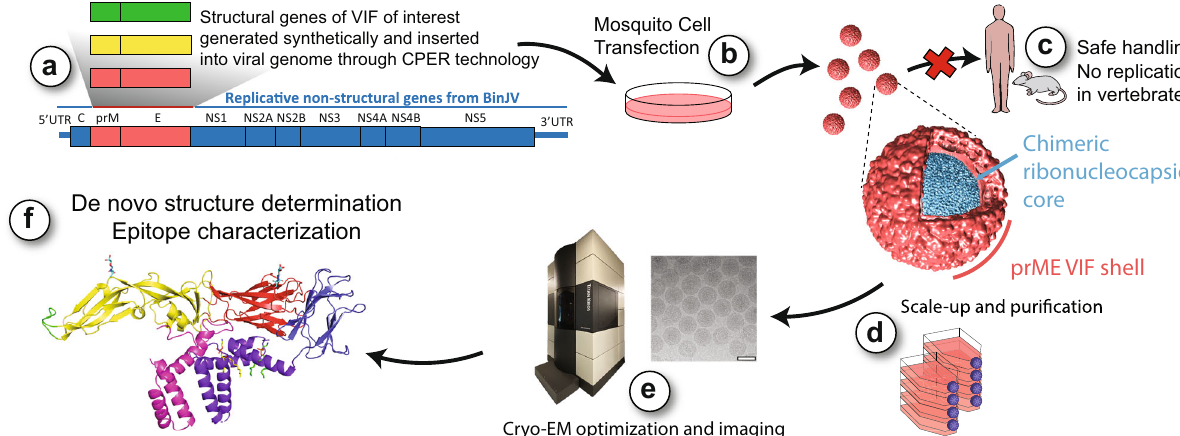
Fig. 1 A chimeric platform for high-resolution structure determination of fl aviviruses particles by cryo-EM. a Structural genes encoding prM and E proteins from a vertebrate-infecting fl avivirus (VIF) are used to replace the homologous genes of the ISF, BinJV, via circular polymerase extension reaction (CPER) methodology. b CPER product is transfected into insect cells to produce a chimeric virus that encodes the replicative machinery of the ISF, but the structural components of the VIF. c Safety and ease-of-use is ensured as the chimeric virus cannot replicate in vertebrate cells. d Chimeric virus production is scaled up and virions puri fi ed for TEM analysis. e Cryo-EM imaging is performed on vitri fi ed virus particles. Scale bar indicates 50 nm. f Single-particle analysis is used to generate high-resolution virion electron density maps, allowing de novo structure elucidation at the atomic scale to inform rational design of new vaccines, therapeutics and